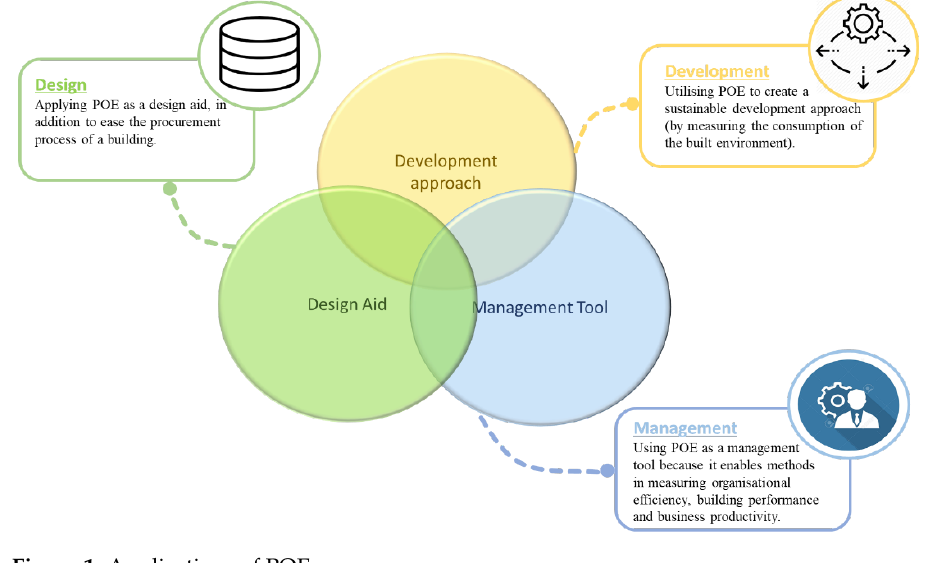
Figure 1. Applications of POE. Table 2. POE feedback techniques Table 2. POE feedback